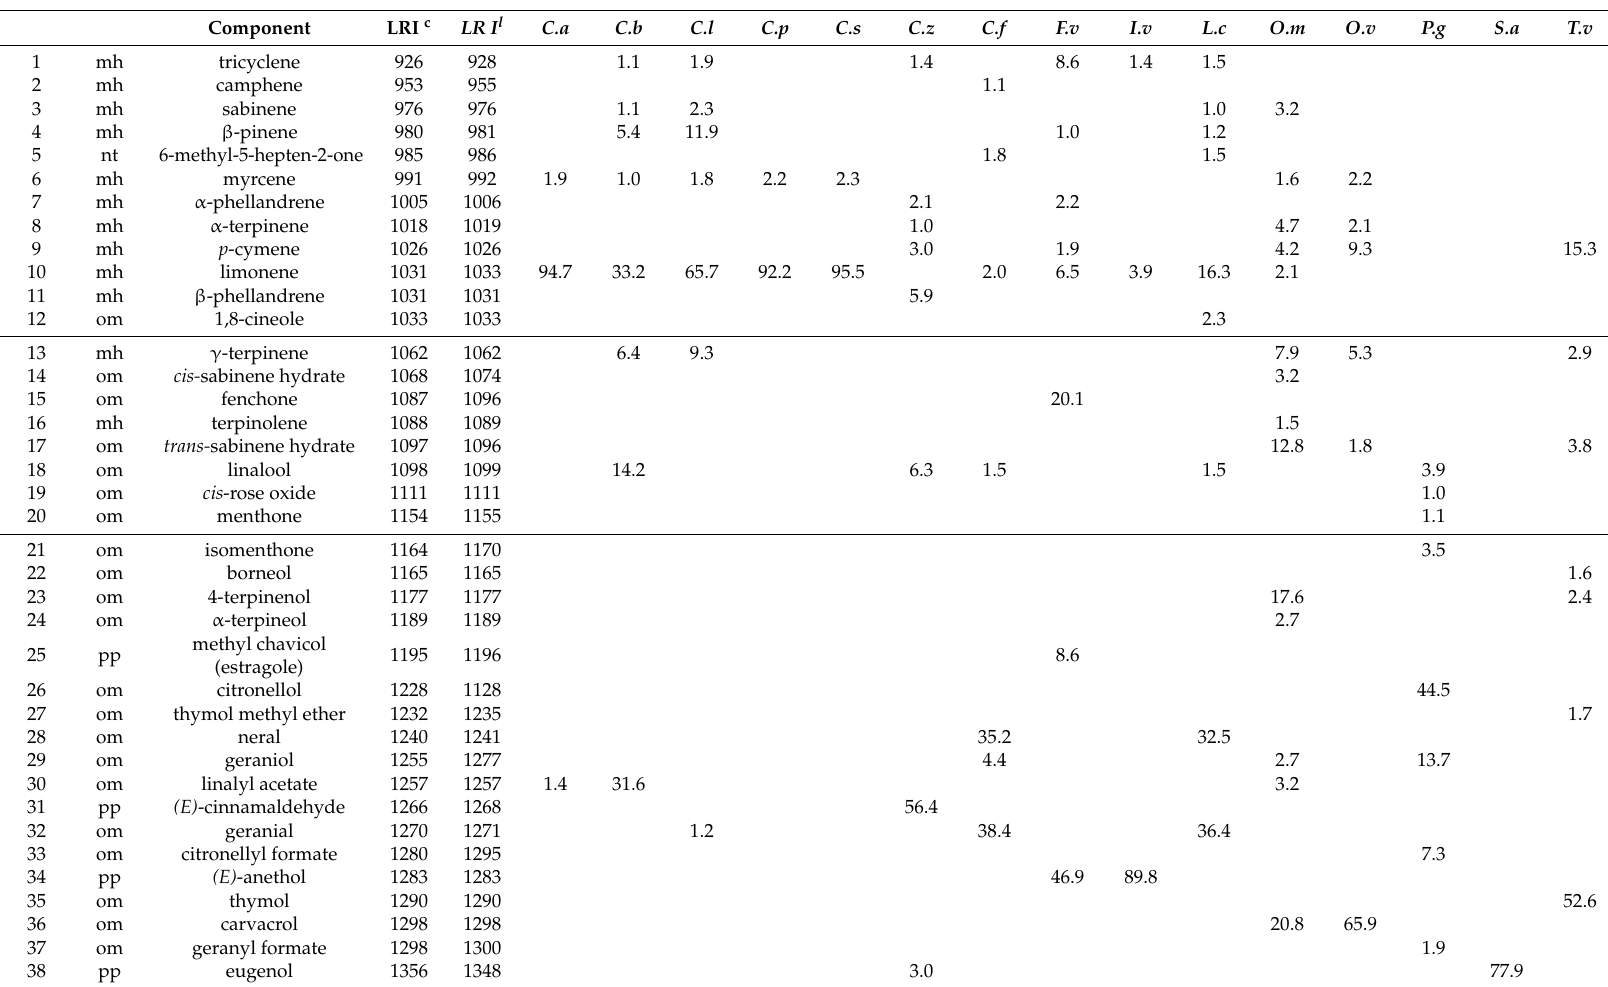
Table 1. Chemical composition of tested essential oils (only compounds present at a concentration ≥ 1% were